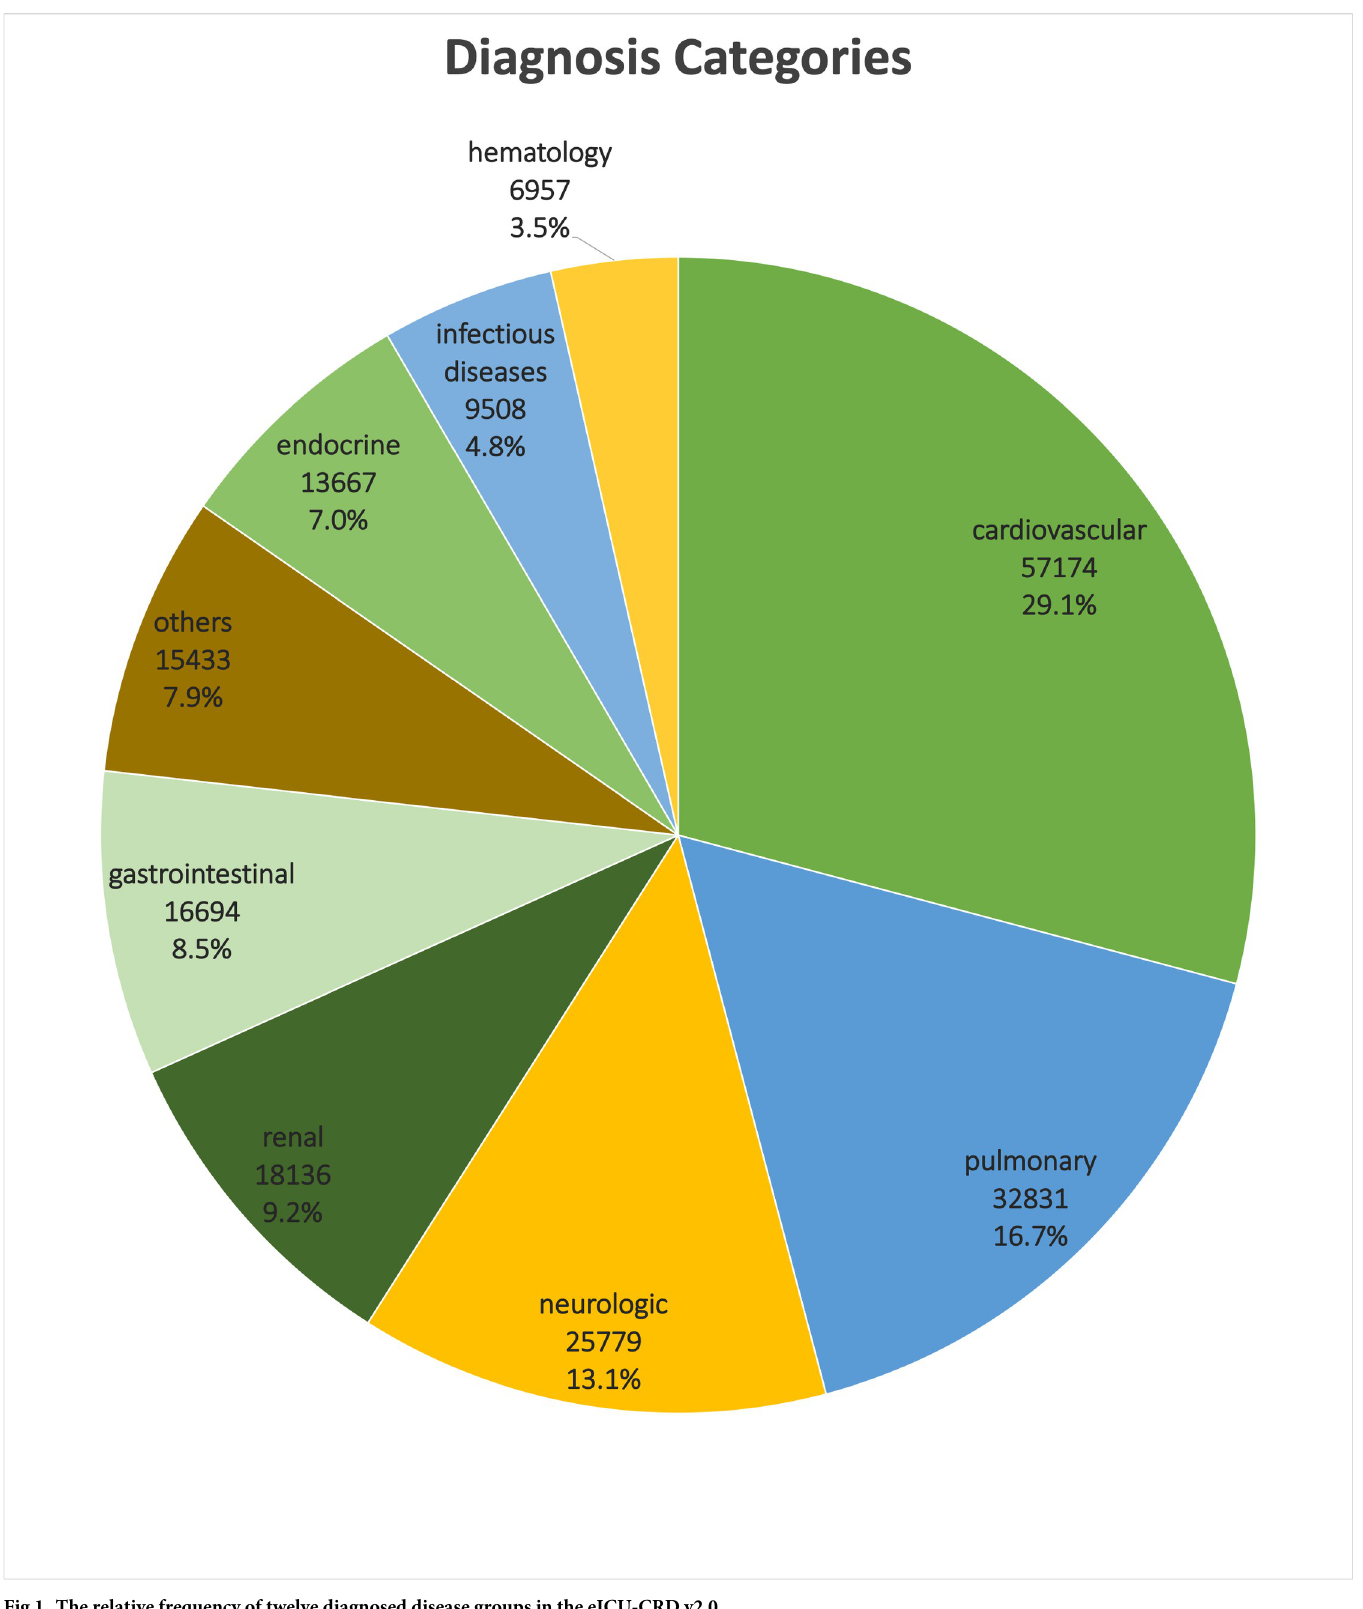
Fig 1. The relative frequency of twelve diagnosed disease groups in the eICU-CRD v2.0.